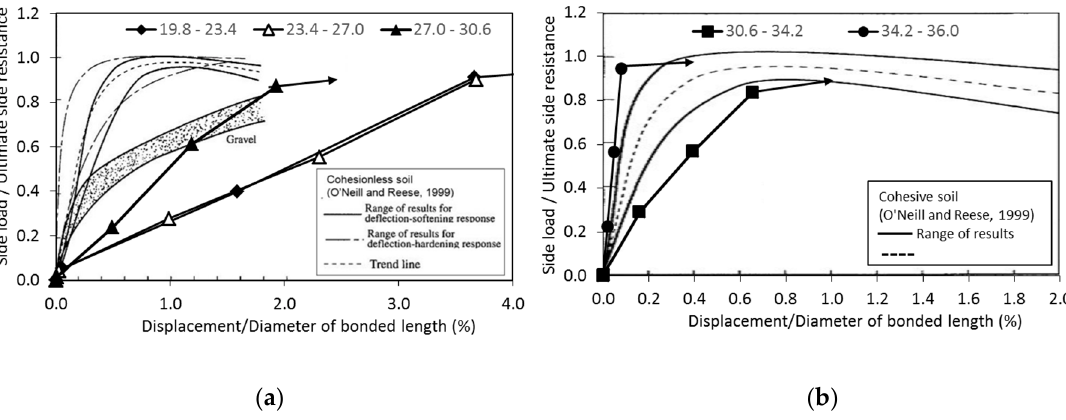
Figure 9. Comparison between obtained transfer curves of anchor T1 and typical transfer curves of side resistance for ( a ) granular and ( b ) fine soils.